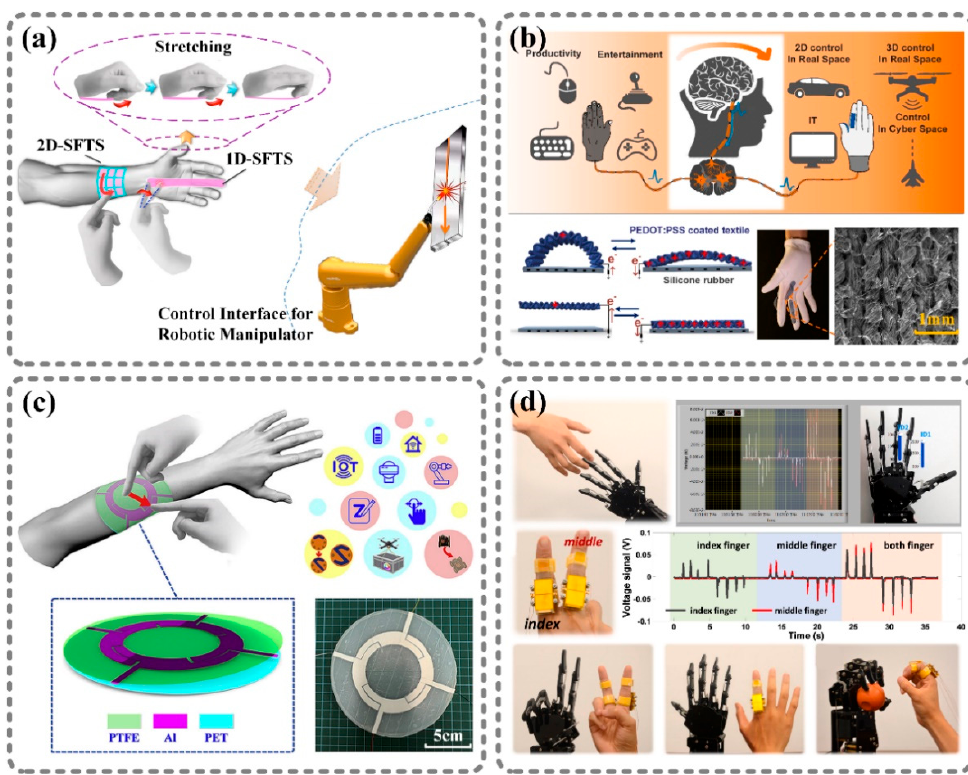
Figure 6. Nanoenergy is collected, analyzed, and converted into standard control signals through a signal-regulating process in order to realize human–machine interfaces. ( a ) Silicon rubber triboelectric patch: a 3D motion control interface for a robotic manipulator based on TENGs [77]. ( b ) PEDOT:PSS- coated textile: an intuitive glove-based interface for machine control. [78]. ( c ) Flexible wearable triboelectric patch: a wearable multi-functional human machine interface [79]. ( d ) Joint motion triboelectric quantization sensor: a system for the synchronous action of a human and a robotic hand [80]. Reproduced with permission from Elsevier [78–80] and American Chemical Society